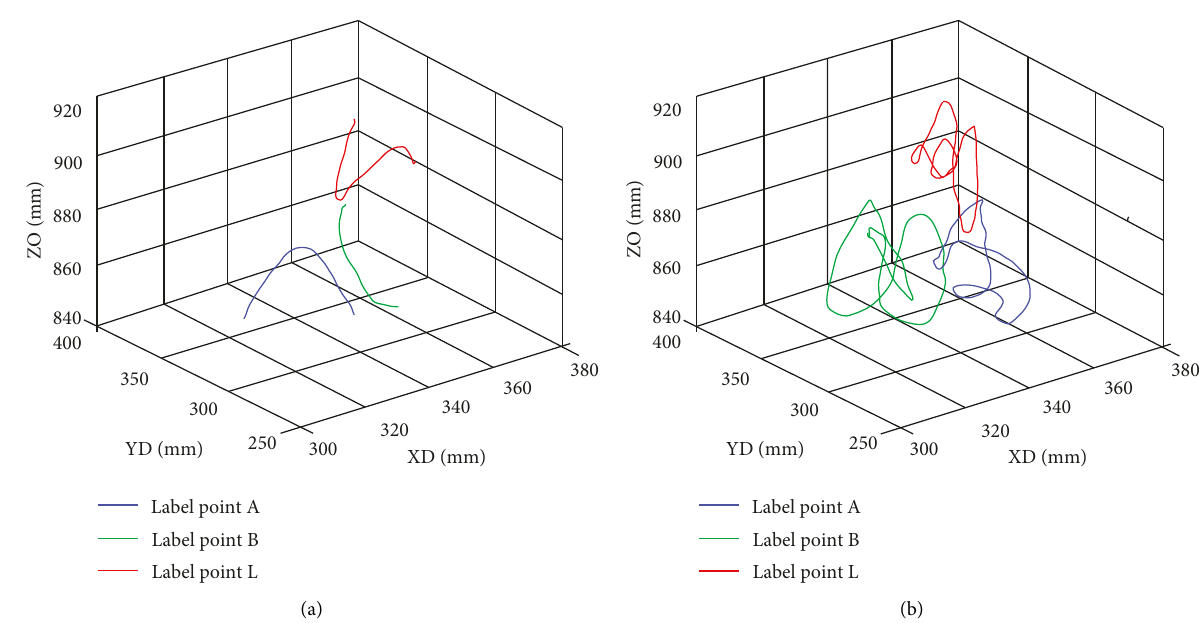
Figure 3: Marker movement track and endpoint tracking track.